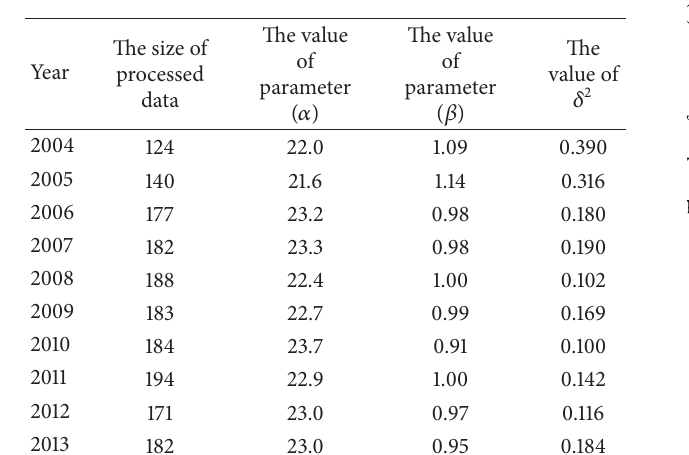
Table 1: Regressive results of new collected data.